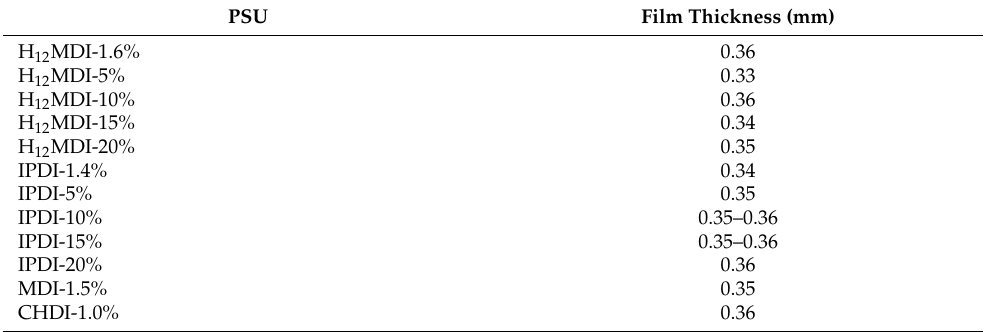
Table A8. Film thicknesses of PSU films measured using a Mitutoyo Digimatic Thickness Gauge Series 547. Values are given as an average from three measurements.